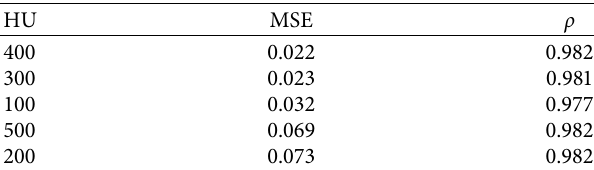
Table 4: Best LSTM NN models identified in the validation stage with ADAM training algorithm and a batch equal to